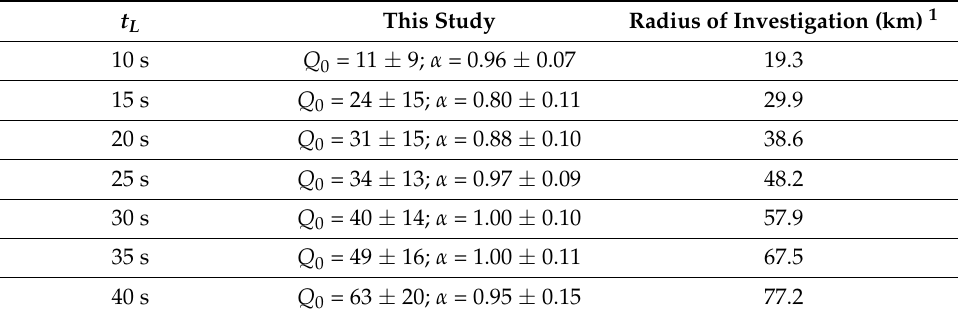
time windows (Table 1). Table 1. For each lapse time t L , Q 0 and α estimates, with their errors and the radius of investigation in the Earth lithosphere, are reported.